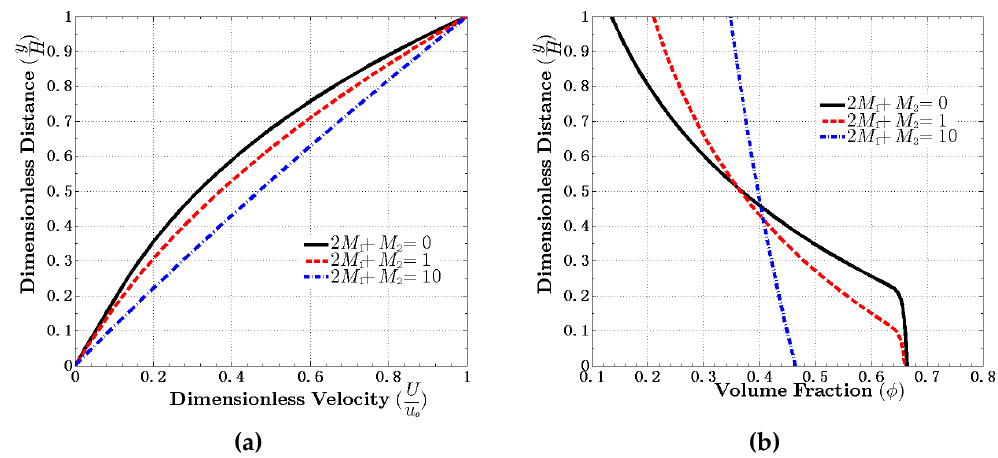
Figure 4. The effect of ( 2 M 1 + M 2 ) on the velocity profile ( a ) and the volume fraction profile ( b ), when R = 1, m = 1, B p = − 1, B r = − 10, φ c = 0.68, S = 100, Fr = 0.5, N =